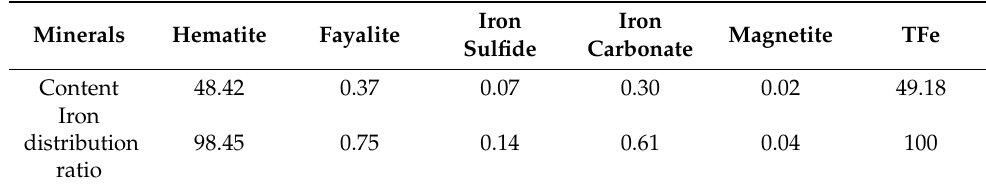
Figure 1. XRD pattern of HPOHO. Table 2. Occurrence of iron in HPOHO.